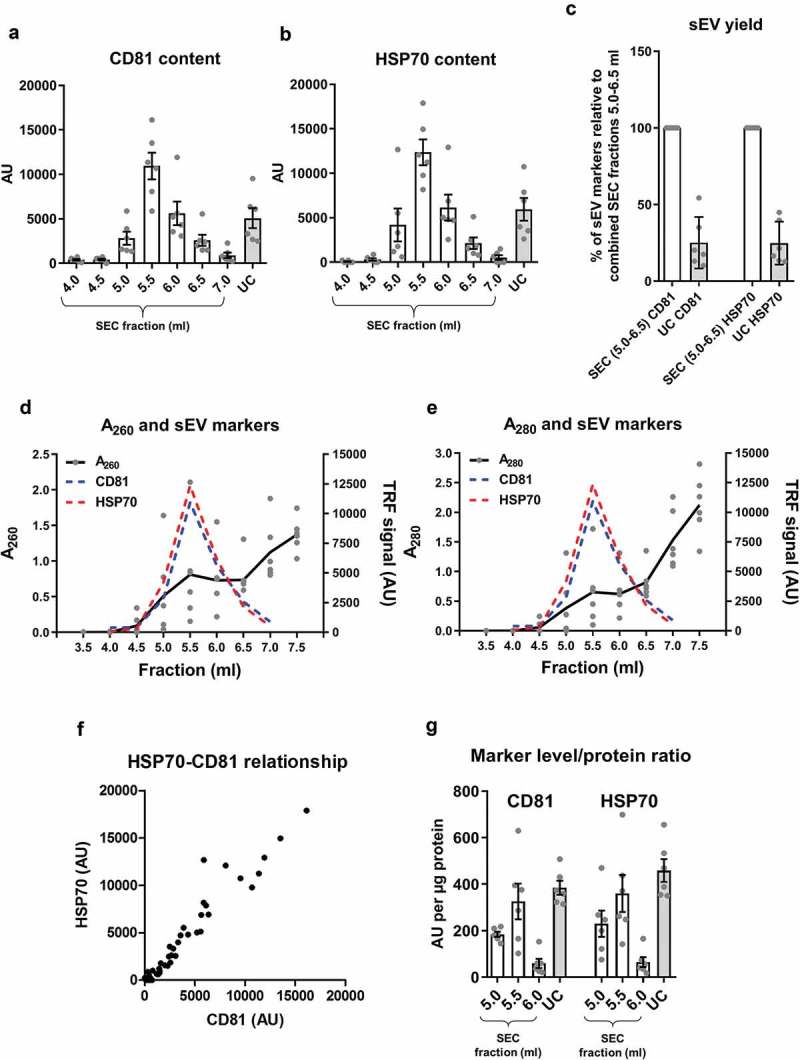
sEV content, as determined by the expression of marker proteins, in rat blood plasma samples obtained using SEC or UC.(a,b): sEV (CD81 – panel (a), HSP70 – panel (b)) markers were measured by DELFIA for SEC fractions 4.0–7.0 ml and UC samples. AU – arbitrary units normalised to volumes in each sample. n = 6. (c): UC sEV yield presented as a % of combined SEC fractions 5.0–6.5 ml CD81 and HSP70 signal (data from (a) and (b)). n = 6. (d,e): Absorbance of SEC samples at 260 nm (A260), representing relative nucleic acid concentrations; and at 280 nm (A280), representing relative protein concentrations. Note the presence of early peaks at both A260 and A280 which coincide with the CD81 and HSP70 marker signal peaks (data from panels (a) and (b), dashed lines). n = 6. (f): Correlation between HSP70 and CD81 signal. SEC fractions 4.0–7.0 ml and UC samples included. p < 0.0001; Spearman’s correlation test, Spearman r = 0.958. n = 48. (g): sEV marker signal (from panels (a) and (b)) was normalised to total protein amount for the peak sEV SEC fractions 5.0–6.0 ml as well as for the UC samples. n = 6.